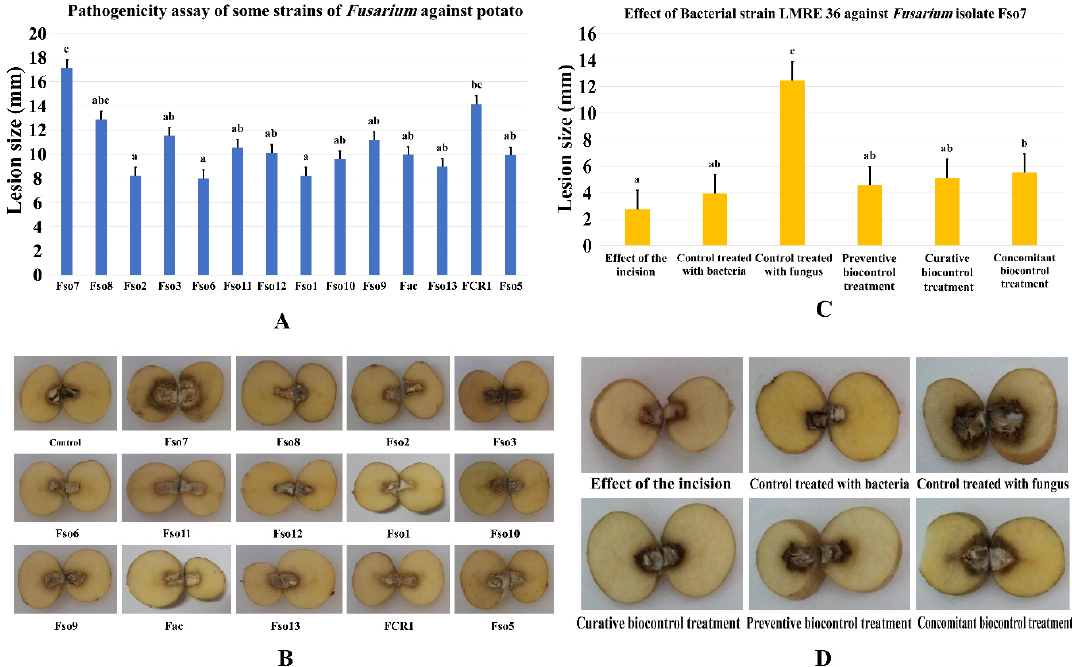
Figure 11. ( A,B ) Pathogenicity assay of Fusarium spp. strains against potato tubers. ( C ) Effects of LMRE 36 bacterial isolate on Fusarium solani strain Fso7 on potato tubers rot severity as compared to controls. ( D ) Effect of preventive, concomitant and curative biocontrol treatment on potato tubers at 10, 22 and 35-days post-inoculation with Fusarium solani strain Fso7. Data presents mean ± standard error. Bars labelled with different letters are significantly different among the treatments at p < 0.05 using Tukey’s HSD test.